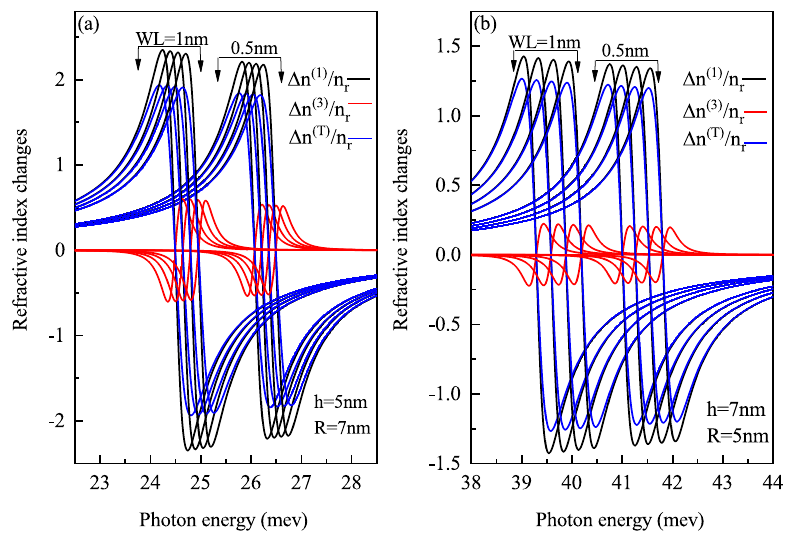
Figure 16. Linear, non-linear and total refractive index changes as a function of the photon energy for ( a ) oblate height h = 5 nm with radius R = 7 nm at WL thickness 0.5 nm and 1 nm ( b ) prolate QD with R = 5 nm, h = 7 nm with WL = 0.5 nm and 1 nm, at four perpendicular electric field strengths of F = 0, 5, 10 and 15 kV/cm from left to right